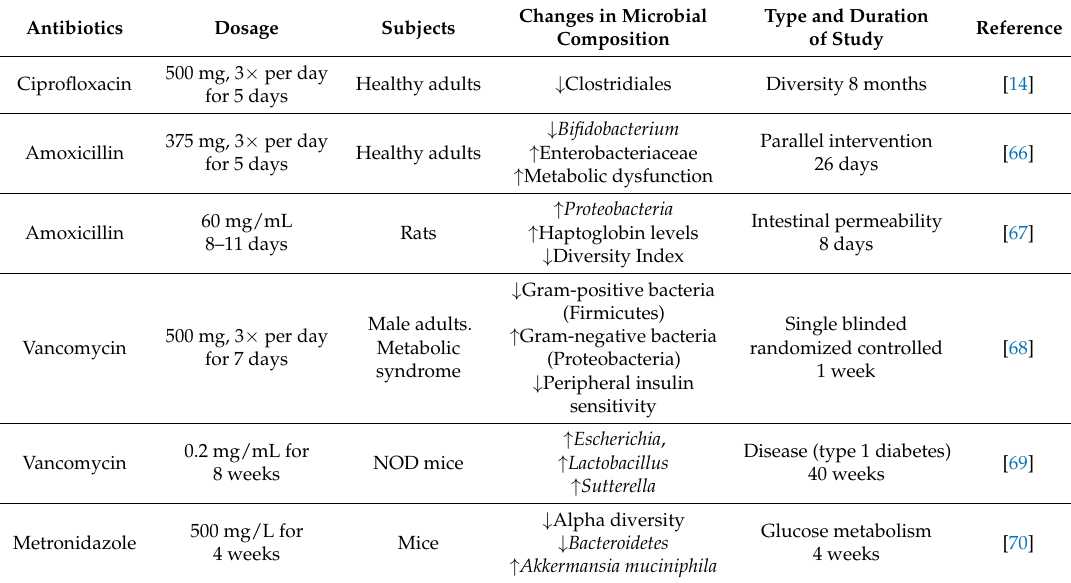
Table 1. Antibiotic treatment effects on the microbiota (both human and